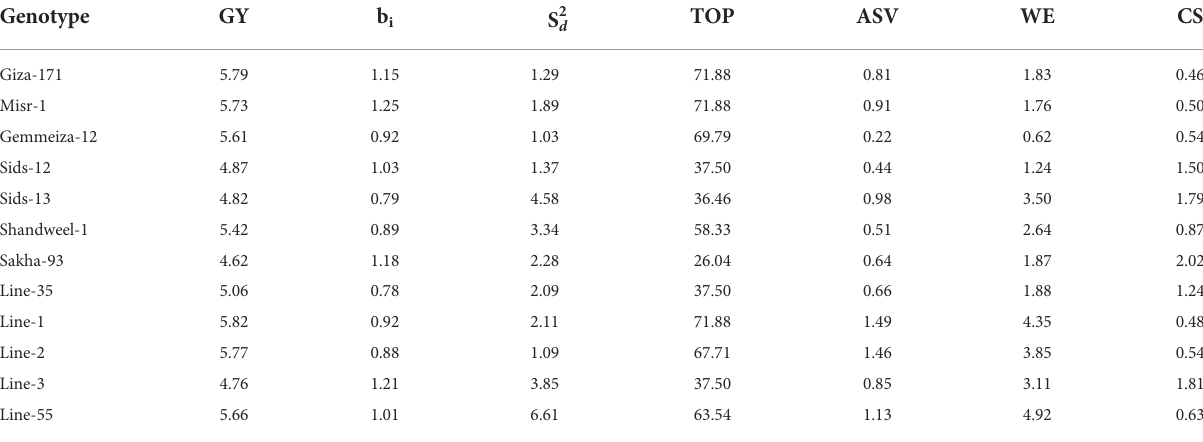
TABLE 9 Stability parameters of twelve bread wheat genotypes tested in eight environments comprising of two locations (Kafer El-Hamam and Sakha), two growing seasons (2015-2016 and 2016-2017) and two sowing dates (timely and late sowing).